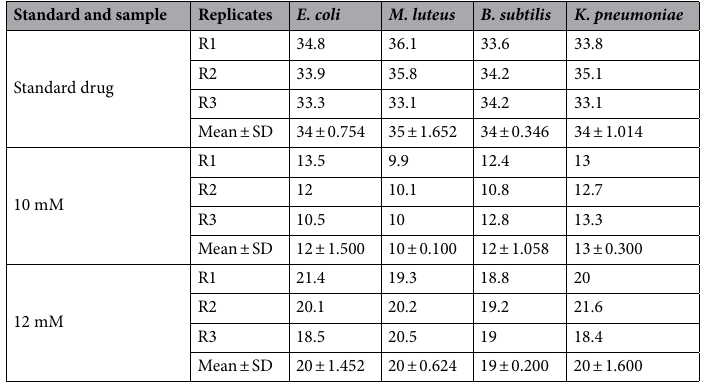
Table 2. Zone of inhibition (mm) of SeNPs synthesized from Citrus paradisi (Grapefruit) fresh peels extract in comparison with the standard drug and control extract against bacterial pathogens. p-value < 0.05.